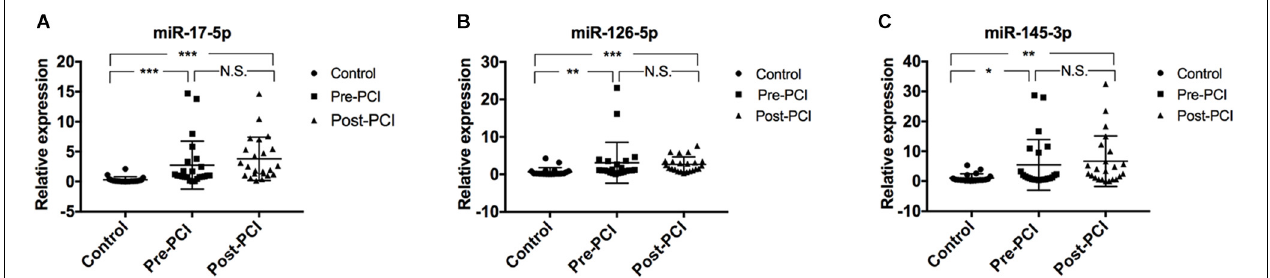
FIGURE 1 | Plasma miRNA levels in the validation population. The scatter plots show the expression levels of (A) miR-17-5p, (B) miR-126-5p, and (C) miR-145-3p measured by quantitative real-time polymerase chain reaction (qRT-PCR) in patients with AMI (including patients before and after PCI operation) ( n = 29) and control subjects ( n = 21). The relative miRNA expression levels were normalized to cel-miR-39 and calculated by – (cid:49)(cid:49) Ct. Differences between each groups were compared by Kruskal-Wallis ANOVA test; ∗ p < 0.05, ∗∗ p < 0.01, ∗∗∗ p < 0.001. Comparisons for which p > 0.5 are denoted as N.S. for no significant difference.